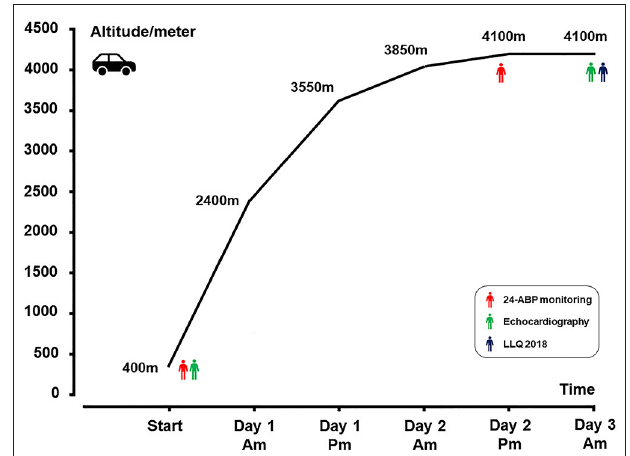
FIGURE 2 | Ascent profile. ABP, ambulatory blood pressure monitoring; LLQ, Lake Louise questionnaire.